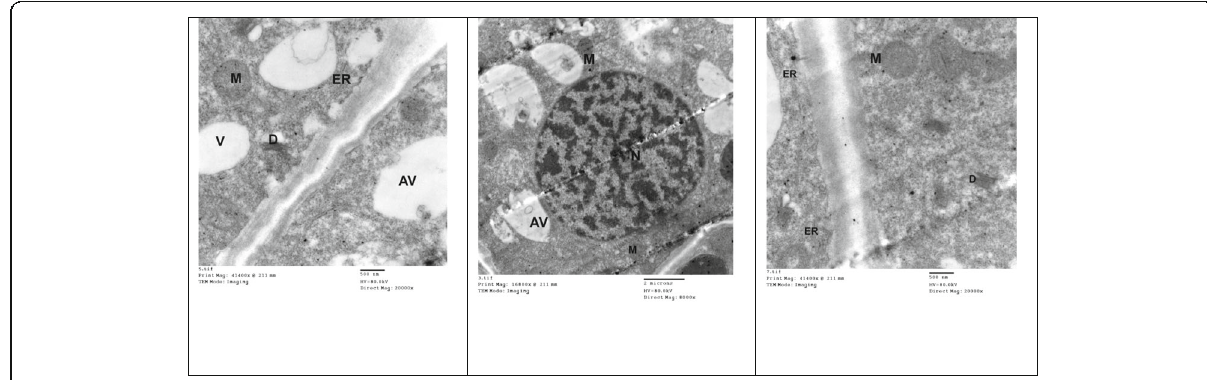
Fig. 3 Ultra-thin section in Allium cepa root tip meristems shows the effect of 3 h of direct treatment with 5.0% Moringa leaf extract on cell organelles: normal size nucleus (N), mitochondria (M), dictyosomes (D), and endoplasmic reticulum (ER) in addition to vacuole (V) and autophagic vacuoles